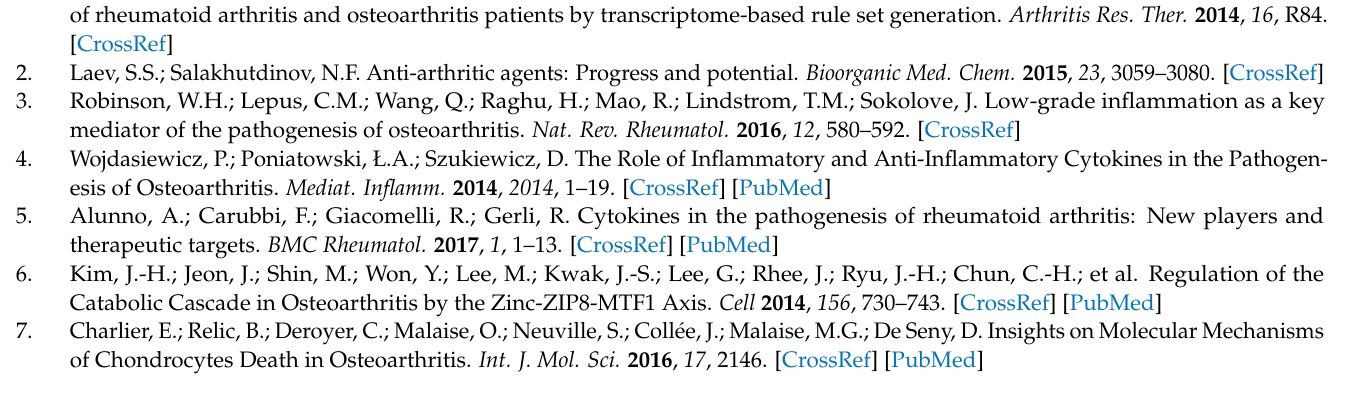
for 24 h, Figure S5: Effects of KP extract on cell viability of SW1353 cell, Figure S6: Full-length blot images of IKK, I κ B, p65, and β -actin, Figure S7; Full-length blot images of JNK, ERK, p38, and β -actin, Figure S8; The chemical structure of standard